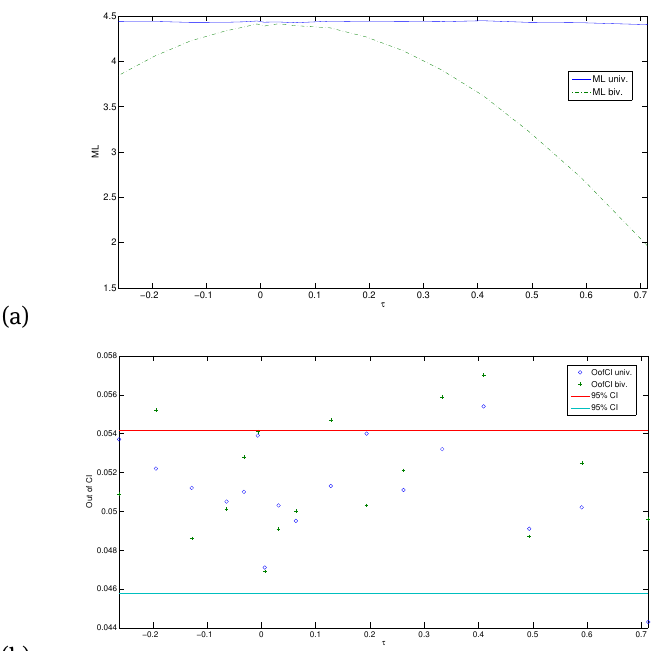
Figure 3: Impact of the dependence between X 1, t and X 2, t −1 , as measured by the average length of the prediction intervals in panel (a). The plain line gives the value of ML α N and the dashed gives the value of (cid:99) ML served values outside of prediction intervals. The circles give the results for prediction intervals based on univariate series while plus signs are for prediction intervals based on bivariate series, and the horizontal lines give the 95% confidence inter- val. For both panels, the x-axis gives the Kendall’tau between X 1, t and X 2, t −1